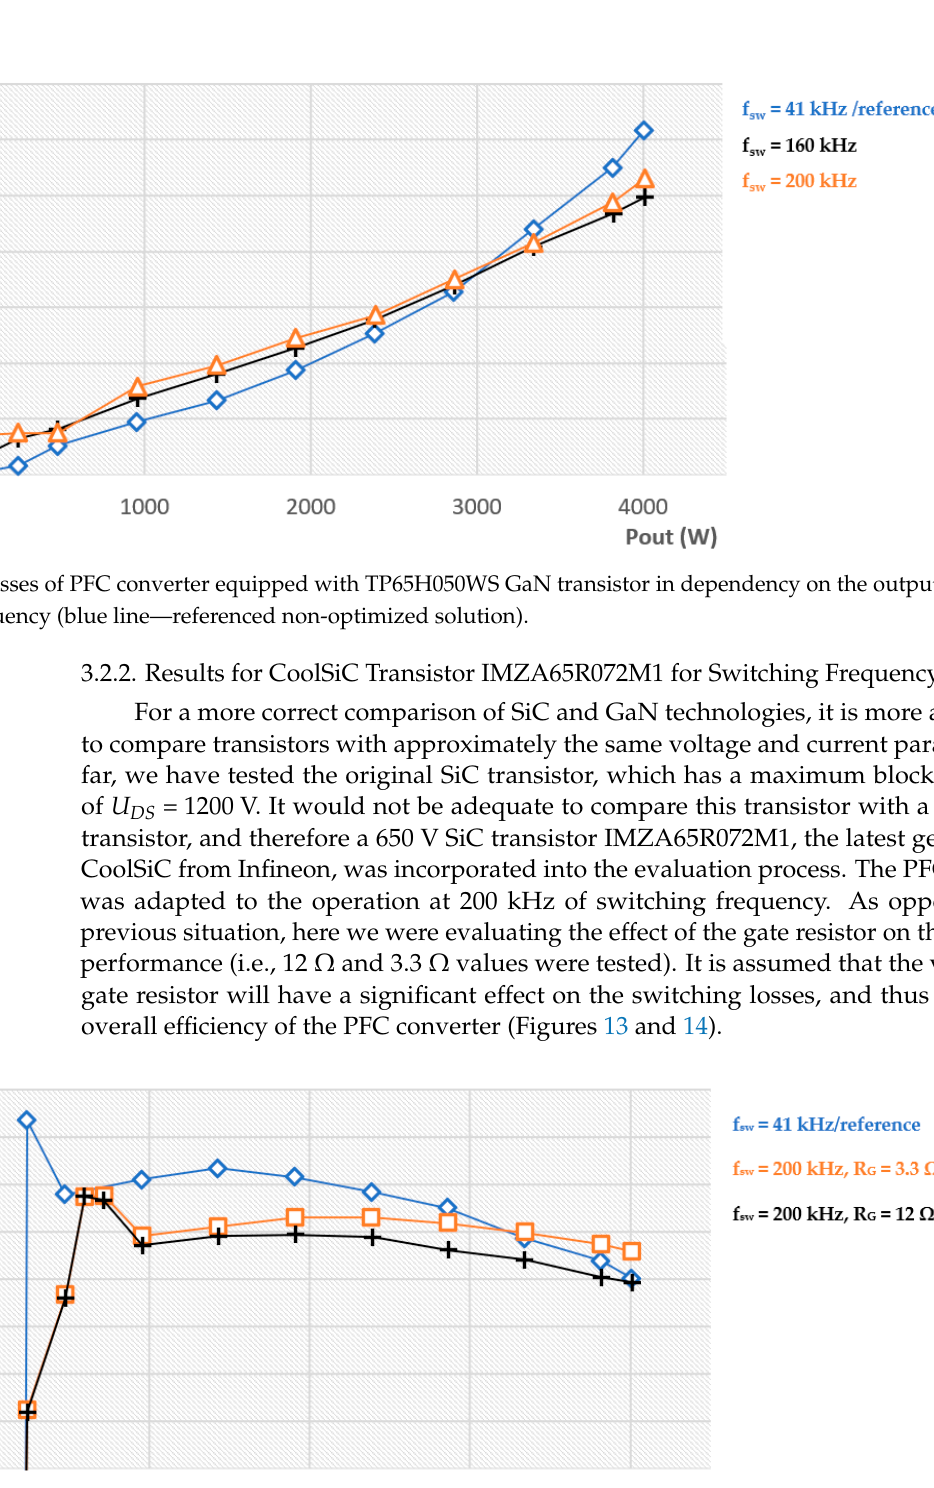
Figure 11. Efficiency characteristic of PFC converter equipped with TP65H050WS GaN transistor in dependency on the output power and switching frequency (blue line—referenced non-optimized solution).